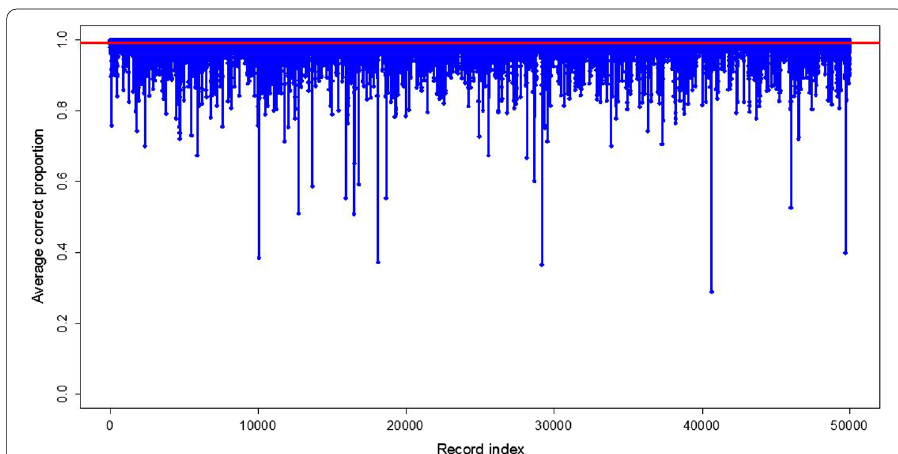
Fig. 8 Correct re-link proportion of each record—average is 0.9911 (red line)